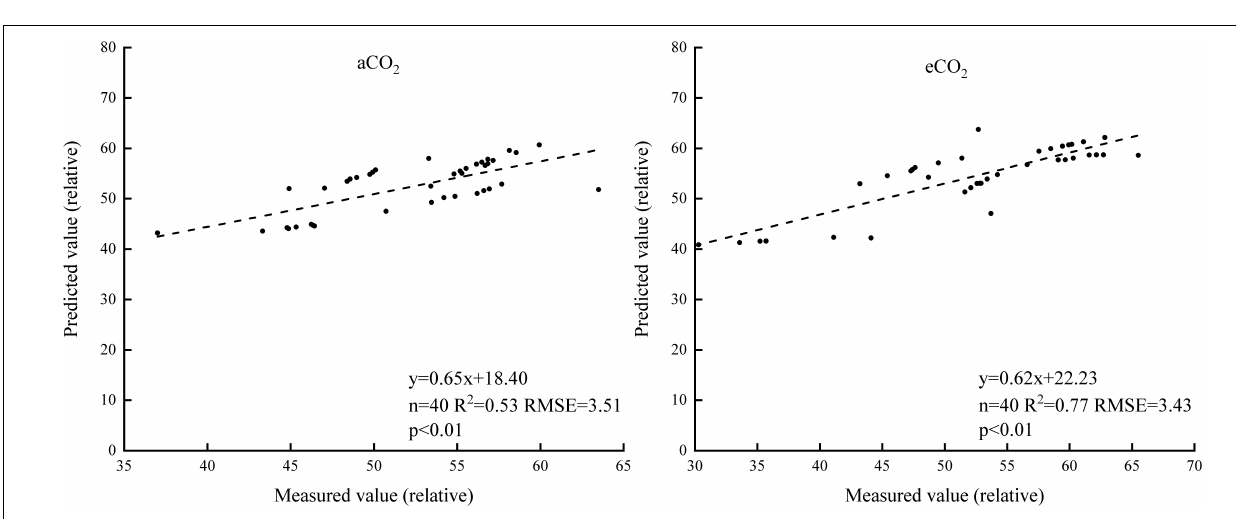
FIGURE 8 | The measured and estimated values of the chlorophyll content based on the DVI model under aCO 2 and eCO 2